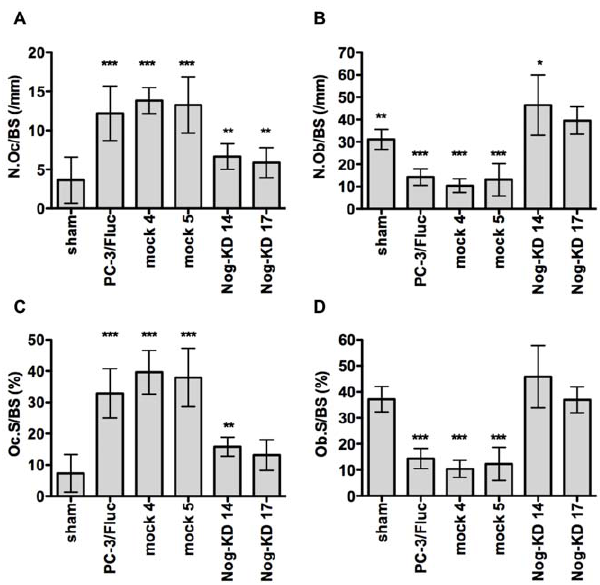
Figure 5. Noggin silencing normalizes the bone histomorpho- metric indexes of bone formation and resorption in osteolytic lesions. A . Number of osteoclasts (N.Oc/BS; /mm, + / 2 SD) on the endosteal surface in trabecular and cortical bone of sham-operated tibiae or on residual bone adjacent to cancer cells of tibiae xenografted with PC-3/F luc , mock and Nog-KD clones. n =6–7 animals for each experimental group. *** P , 0.001, PC-3/F luc and mock clones versus sham, and mock clones versus Nog-KD 17; ** P , 0.01, Nog-KD 17 versus PC-3/F luc, and Nog-KD 14 versus PC-3/F luc and mock clones. B . Number of osteoblasts (N.Ob/BS; /mm, + / 2 SD) on the endosteal surface in trabecular and cortical bone of sham-operated tibiae or on residual bone adjacent to cancer cells of tibiae xenografted with PC-3/F luc , mock and Nog-KD clones. n =6–7 animals for each experimental group. *** P , 0.001, PC-3/F luc and mock clones versus Nog-KD clones, and mock 4 versus sham; ** P , 0.01, sham versus PC-3/F luc and mock 5; * P , 0.05, Nog-KD 14 versus sham. C . Percentage of endosteal surface in cortical and trabecular bone occupied by osteoclasts (Oc.S/BS; %, + / 2 SD) in sham-operated and cancer cell-xenografted tibiae. n =6–7 animals for each experimental group. *** P , 0.001, mock clones versus sham and Nog-KD clones, and PC-3/F luc versus sham and Nog-KD 17; ** P , 0.01, Nog-KD 14 versus PC-3/F luc . D . Percentage of endosteal surface in cortical and trabecular bone occupied by osteoblasts (Ob.S/ BS; %, + / 2 SD) in sham-operated and cancer cell-xenografted tibiae. n =6–7 animals for each experimental group. *** P , 0.001, PC-3/F luc and mock clones versus sham and Nog-KD clones.